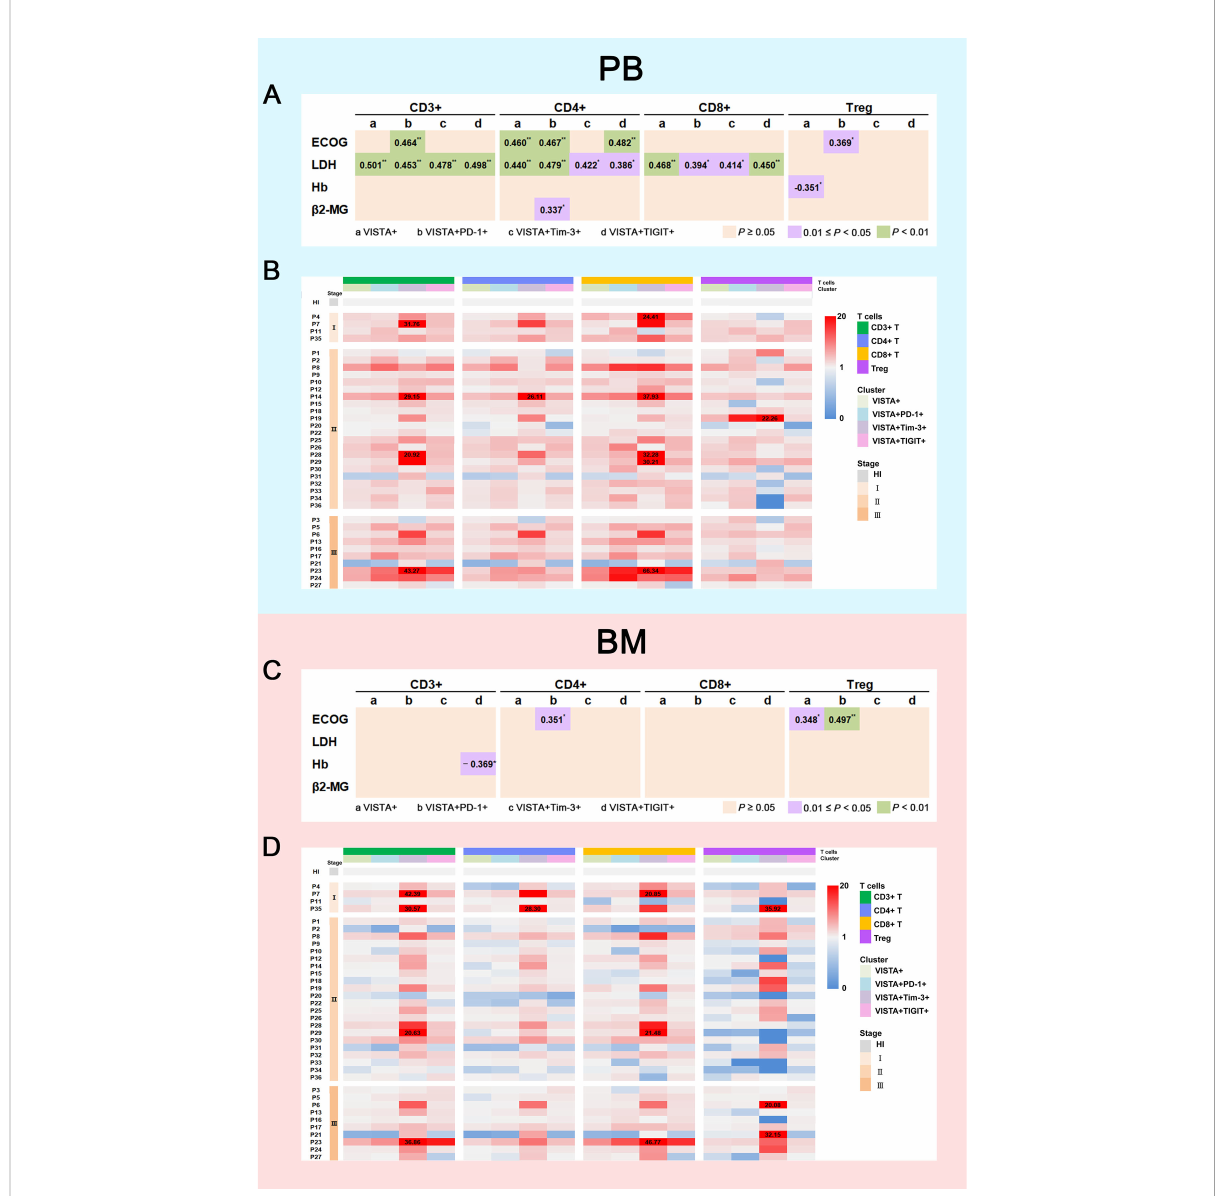
FIGURE 4 Correlation between VISTA expression on T cell subsets and clinical indicators. (A) Correlation between the percentages of VISTA+, VISTA+PD-1 +, VISTA+Tim-3+, and VISTA+TIGIT+ T cells on T cell subsets in PB and ECOG scores, LDH, Hb, and b 2-MG levels (*P < 0.05; **P < 0.01). (B) Heatmap representing the frequency of VISTA+, VISTA+PD-1+, VISTA+Tim-3+, and VISTA+TIGIT+ T cells on T cell subsets in PB from MM patients of different R-ISS stages compared with HIs. (C) Correlation between the percentages of VISTA+, VISTA+PD-1+, VISTA+Tim-3+, and VISTA+TIGIT+ T cells on T cell subsets in BM and ECOG score, LDH, Hb, and b 2-MG levels. (D) Heatmap representing the frequency of VISTA+, VISTA+PD-1+, VISTA+Tim-3+, and VISTA+TIGIT+ T cells on T cell subsets in BM from MM patients of different R-ISS stages compared with